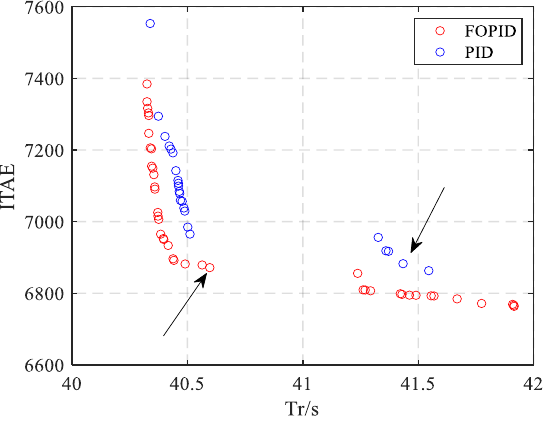
Figure 13. Comparison diagram of the Pareto archive of four schemes. Table 4. Optimal solution of the best solution.